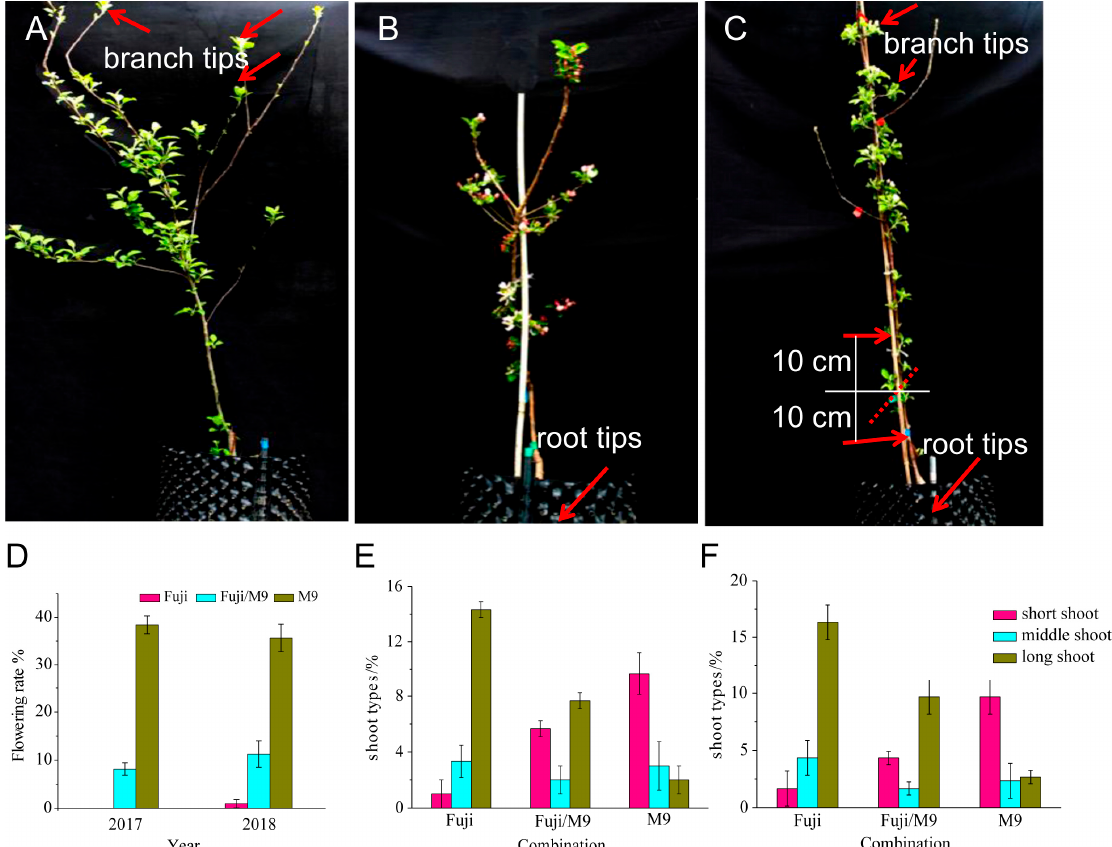
Figure 1. Phenotypic and physiologic differences of self-rooted Fuji, self-rooted M9, and grafted Fuji/M9: ( A ) Fuji, ( B ) M9, ( C ) Fuji/M9, ( D ) flowering rate in 2017 and 2018, ( E ) shoot type in 2017, ( F ) shoot type in 2018.